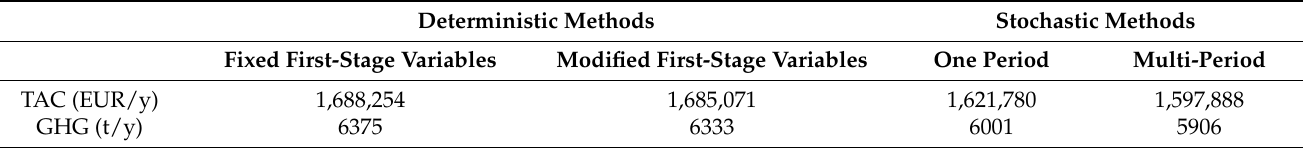
Table 10. Comparison of HEN results with different approaches (different time periods).